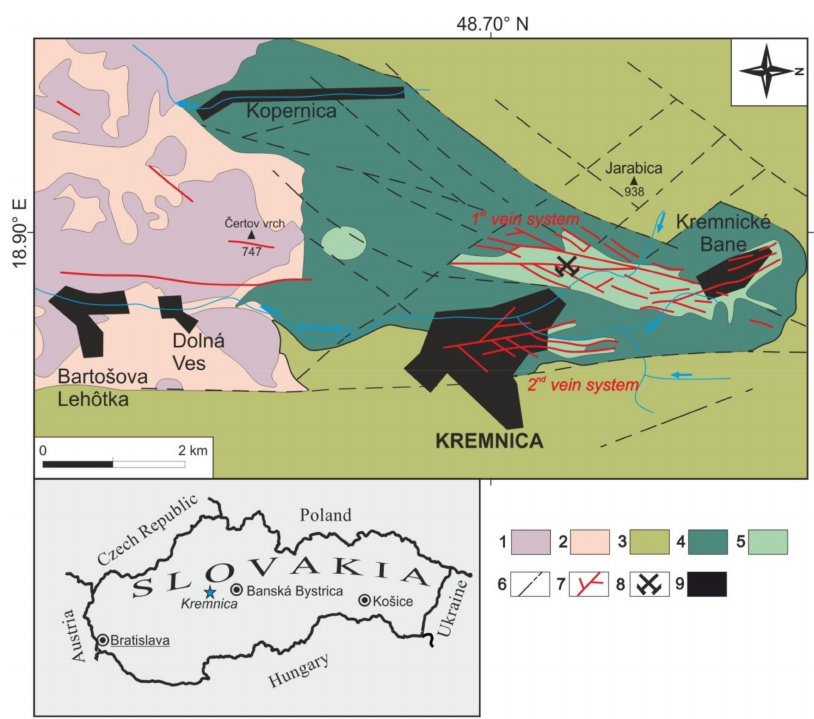
Figure 1. Geological map of the study area. Explanations: 1—rhyolite, 2—rhyolite tuffs, 3—Kremnica graben andesites, 4—pre-graben andesites, 5—hydrothermally altered rock, affected mostly by kaolinization and adularization, 6—faults, 7—epithermal veins, 8—position of the V á clav-south adit, 9—villages and towns. Adapted with permission from Kodˇera and Lexa